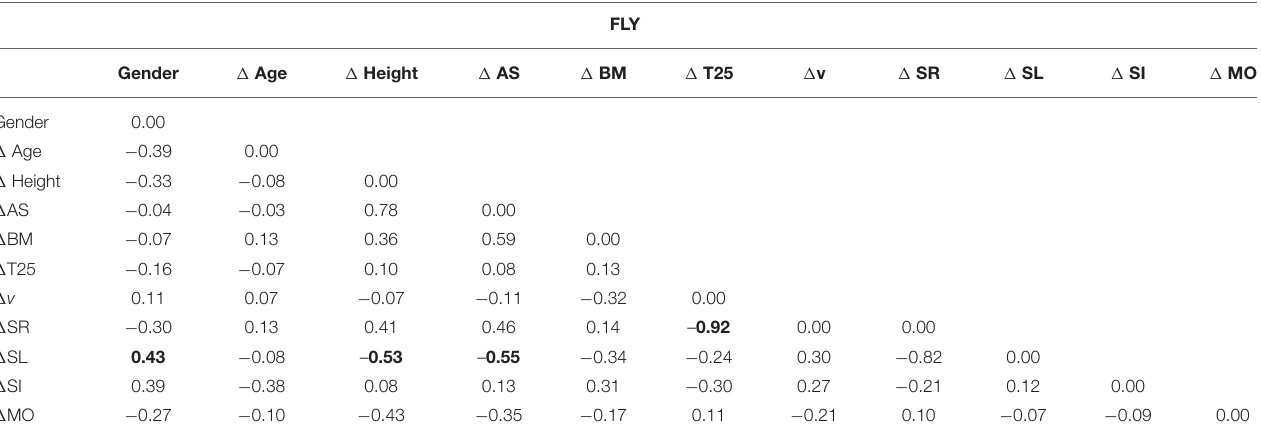
TABLE 3 | The weight matrix for the FLY with the 1 % (gender (gender as a dichotomous variable) ( n = 20).